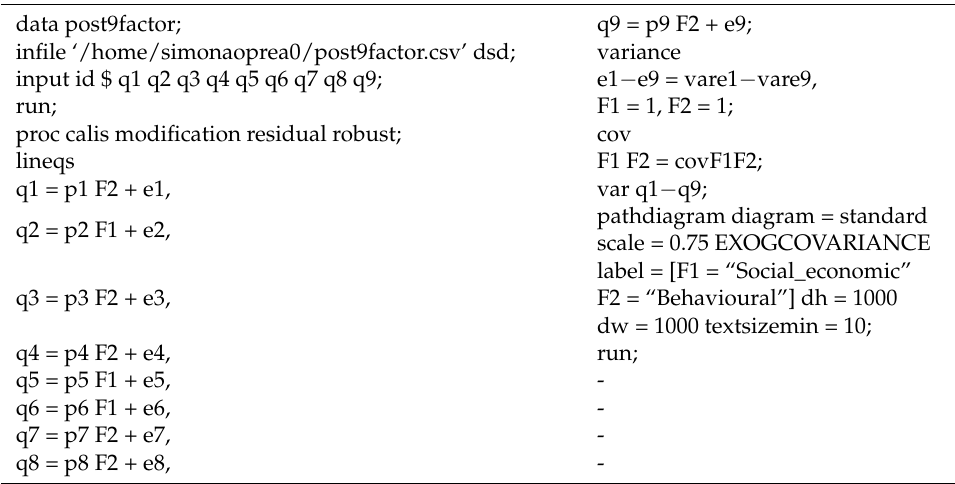
Table 2. CALIS implementation of the first-order CFA model for the pre-trial questionnaire. data